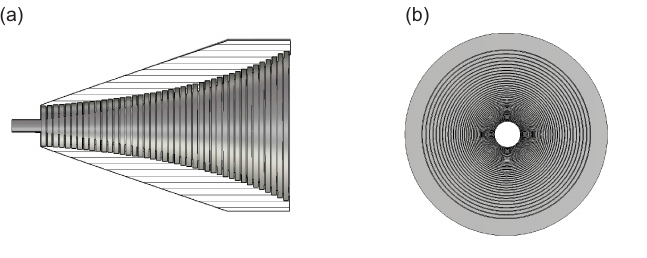
Figure 17. Model of the corrugated horn. In side view ( a ) and in frontal view ( b ).